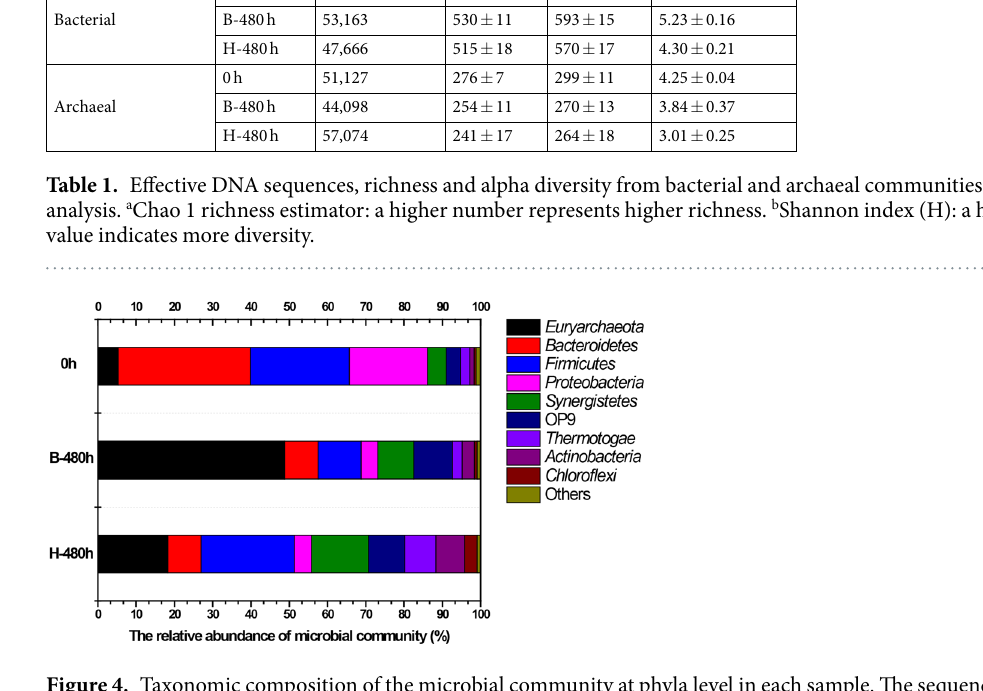
Figure 4. Taxonomic composition of the microbial community at phyla level in each sample. The sequence percentage is above 1% in at least one